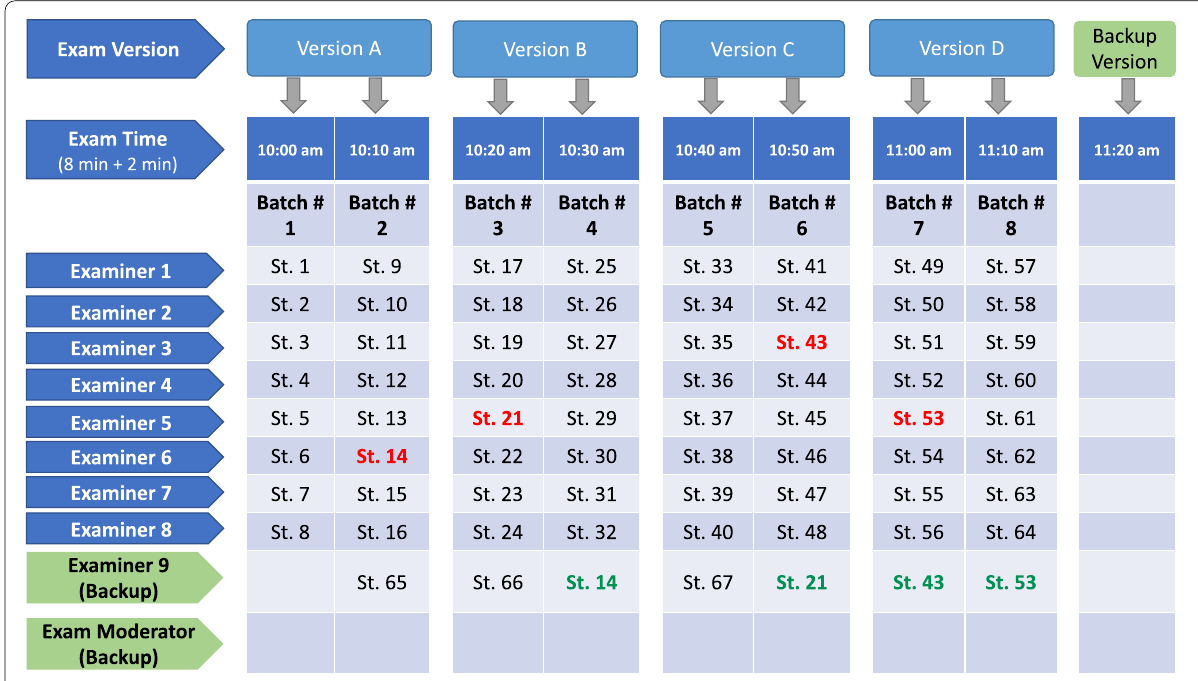
Fig. 3 The SOE execution plan outlining the distribution (time, examination version and examiner room) for 67 students (St.1 to St. 67). Students highlighted in red (students # 14, 21, 43, and 53) had connectivity problems initially at their scheduled examination time, but they have been successfully re-allocated and examined in the backup examination room (highlighted in green). There was no need to utilize the second backup examination room (examination moderator room) and the backup examination version